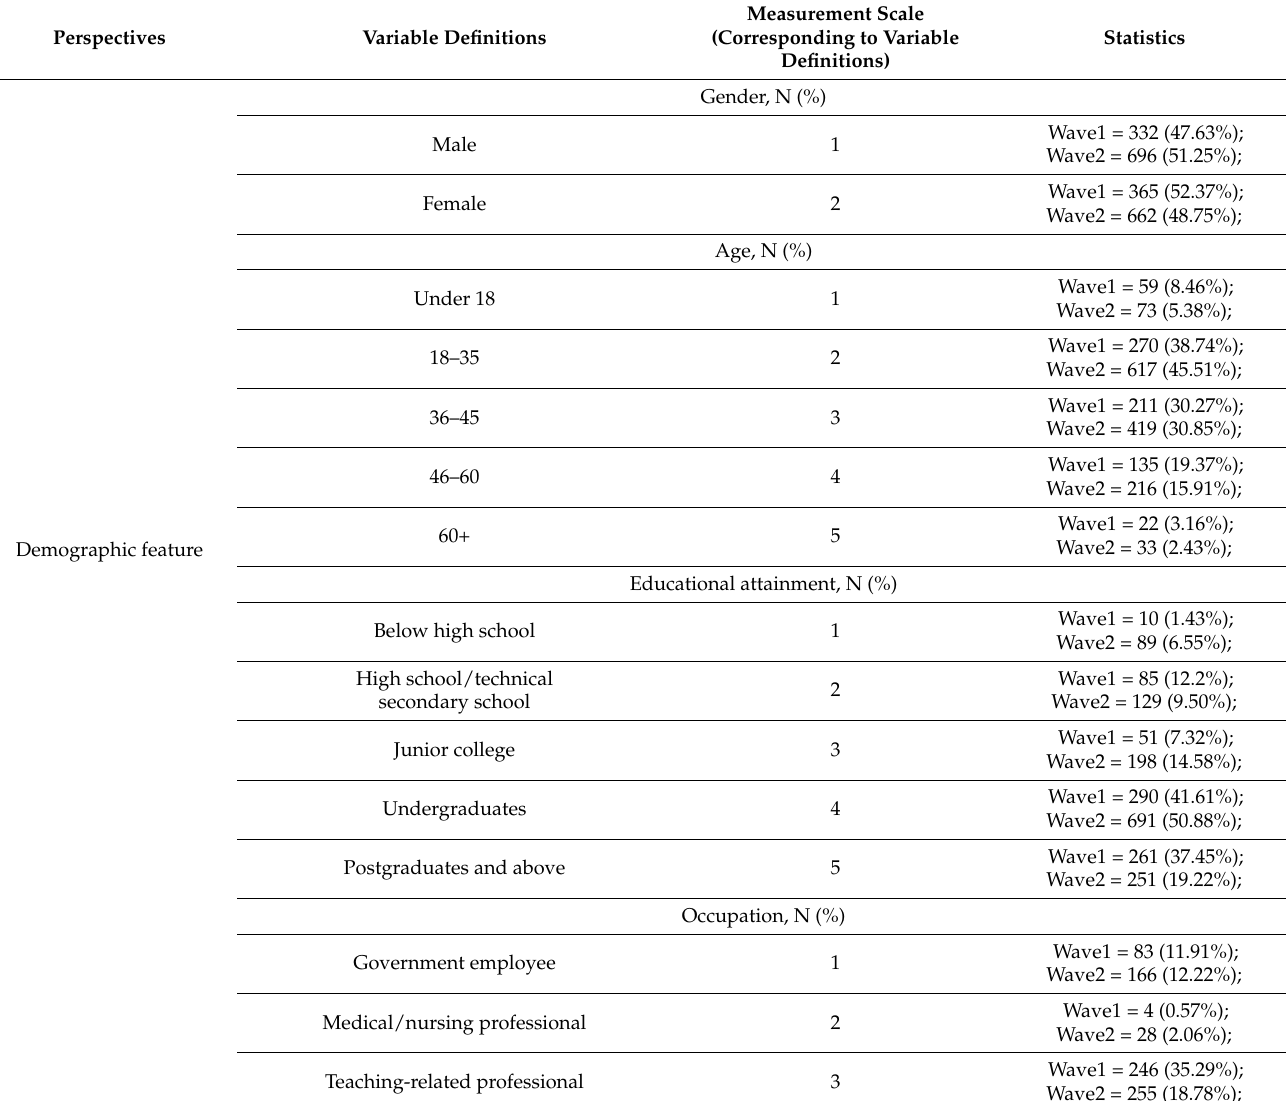
Table 1. Questionnaire design and basic